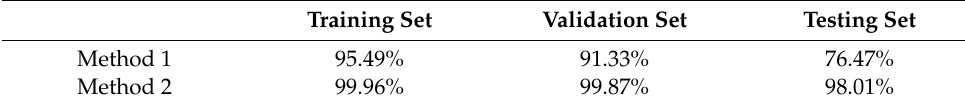
Table 12. The identification accuracy rate of the two methods.